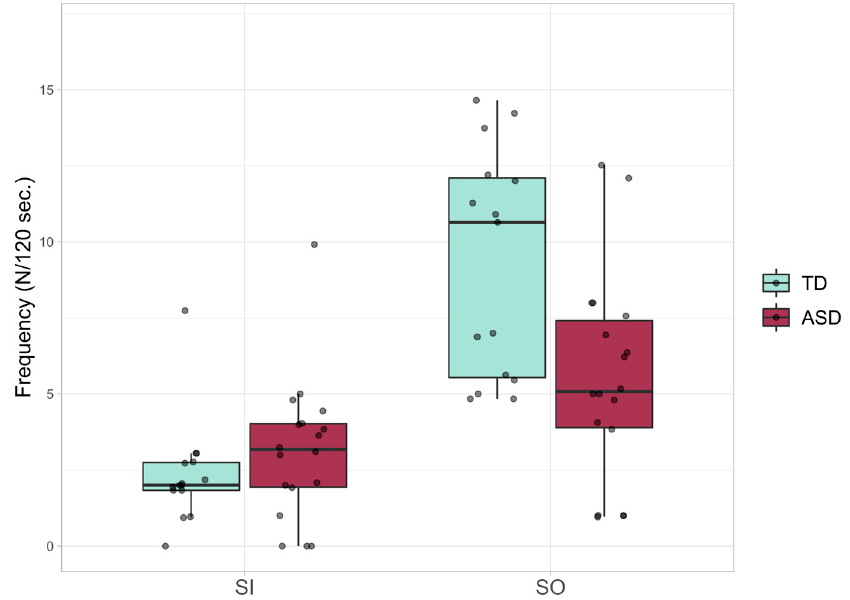
Figure 3. Smile Frequency; boxplots of the average frequency for Simple (SI) and Social (SO) Smiles in ASD and TD groups. Frequency is expressed in terms of the number of expressions over 120 s of interaction.